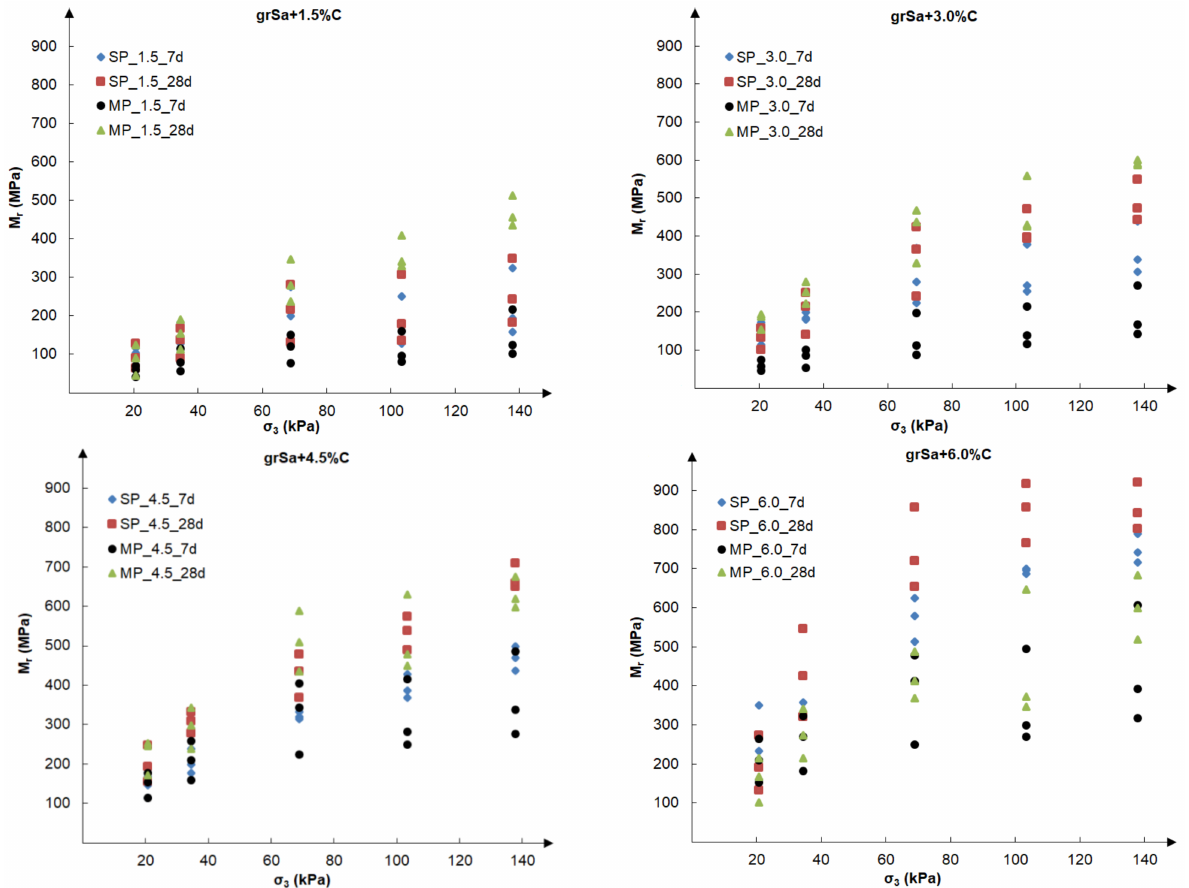
Figure 8. The results of final resilient modulus vs. confining pressure obtained for samples compacted by the SP and MP methods after 7 and 28 days of curing for the various cement